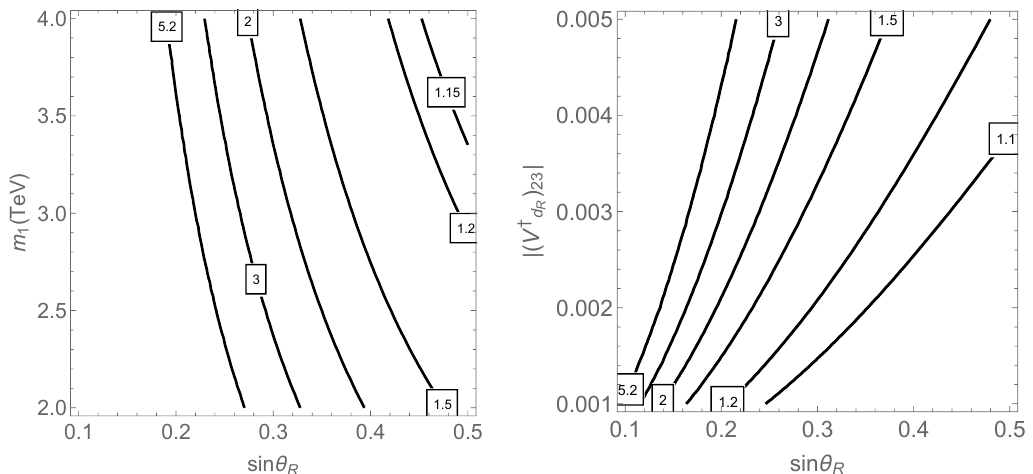
where we have used the upper bound on K